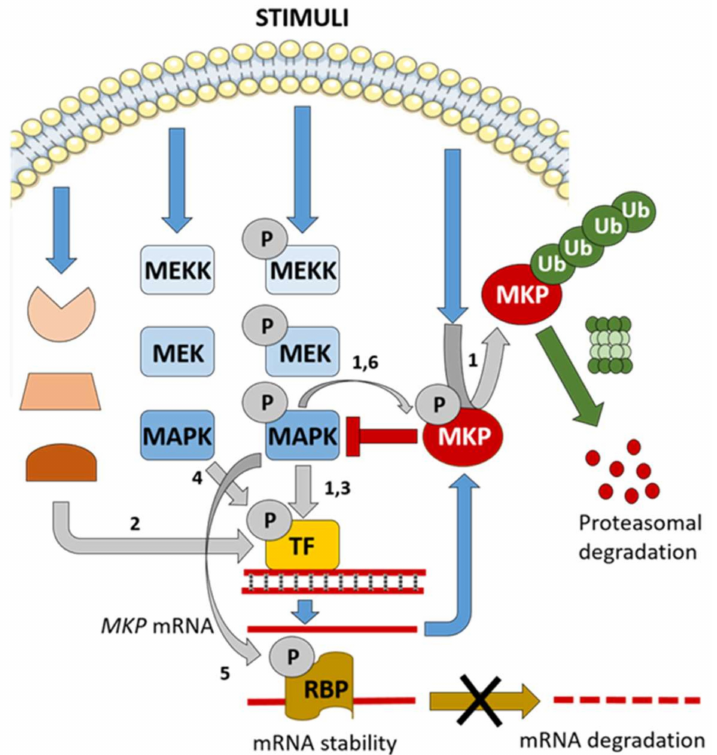
Figure 4. Multiple levels of MKP regulation in fungi. In response to stress, MKP gene expression can be transcriptionally induced by a transcription factor (TF) activated by either the MAPK target of the MKP, another related MAPK pathway, or another route. The stability of the MKP mRNA can be post-transcriptionally regulated by an RNA-binding protein (RBP), which increases the mRNA half-life and thereby the amount of MKP protein. The activity of the RBP can be in turn modulated by phosphorylation by the target MAPK. After translation, the MKP can be further regulated by different post-translational modifications, such as phosphorylation or ubiquitination. MKP phosphorylation is usually exerted by its target MAPK and ubiquitination generally leads to MKP degradation by the proteasome. Numbers designate the fungal MKPs known to be under the regulatory mechanisms indicated by grey arrows: ( 1 ) S. cerevisiae Msg5, ( 2 ) S. cerevisiae Sdp1, ( 3 ) U. maydis Rok1, ( 4 ) C. albicans Cpp1, ( 5 ) S. pombe Pmp1, and ( 6 ) P. oryzae